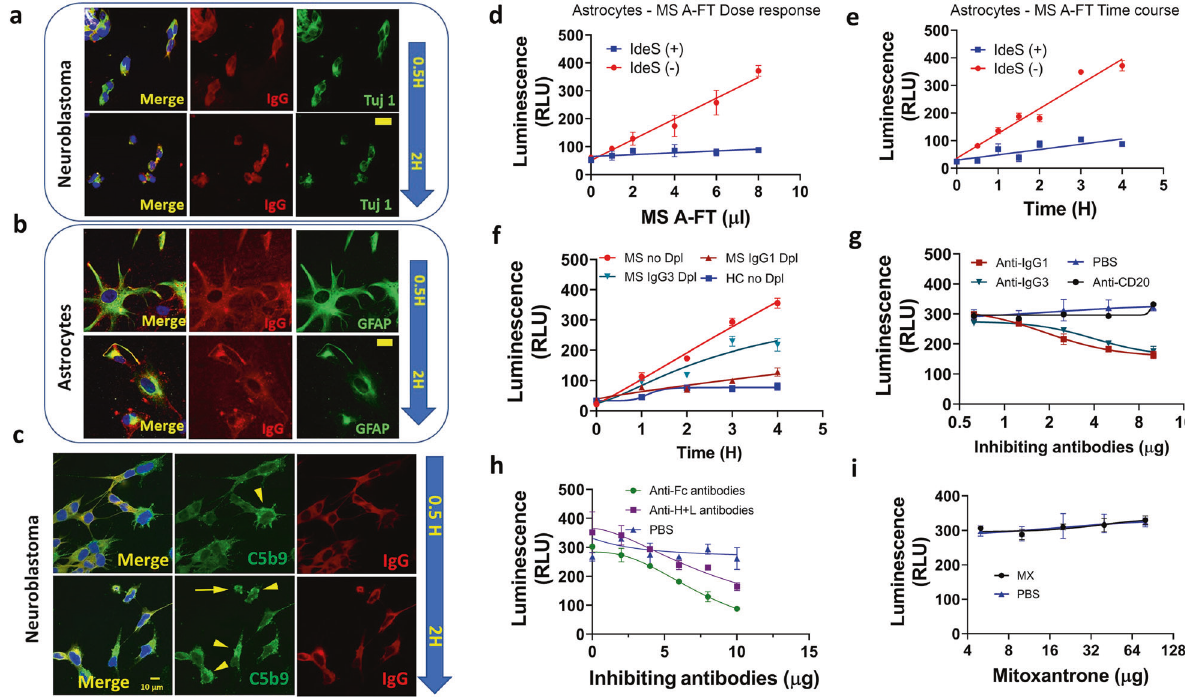
Fig. 3 IgG antibody-mediated, complement-dependent neuronal apoptosis by MS A-FT. a , b Time course of confocal microscopy showing the presence of IgG antibodies in neuroblastoma ( a ) and astrocytes ( b ) treated with MS A-FT. IgG positive staining was observed after 30 min treatment and cell damage/death was more prominent after 2 h in both cells. Both IgG and cell markers were shown in the membrane- compromised/dying cells in a time-dependent manner. Scale bars: 20 µm ( a ), 10 µm ( b ). c Time course of immunostaining of